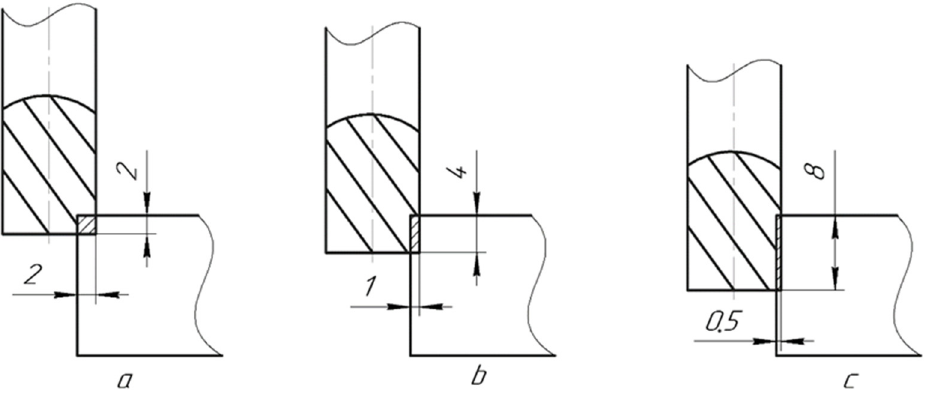
Figure 4. Milling pattern. ( a ) Milling width Ae = 2 mm, depth Ap = 2 mm, ( b ) milling width Ae = 1 mm, depth Ap = 4 mm, ( c ) milling width Ae = 0.5 mm, depth Ap = 8 mm.